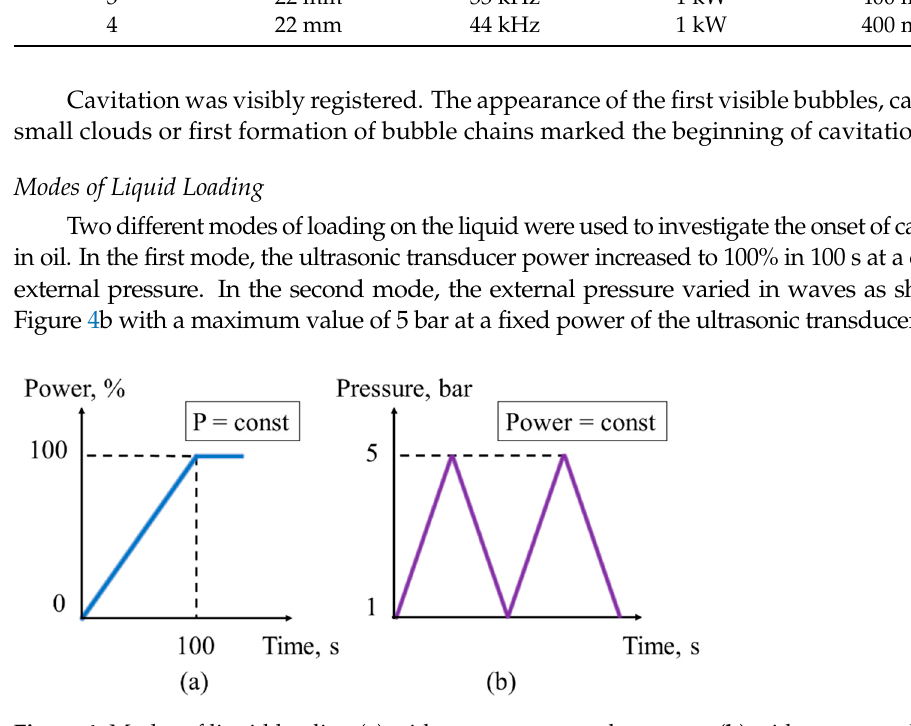
Figure 4. Modes of liquid loading ( a ) with constant external pressure; ( b ) with constant ultrasonic transducer power.